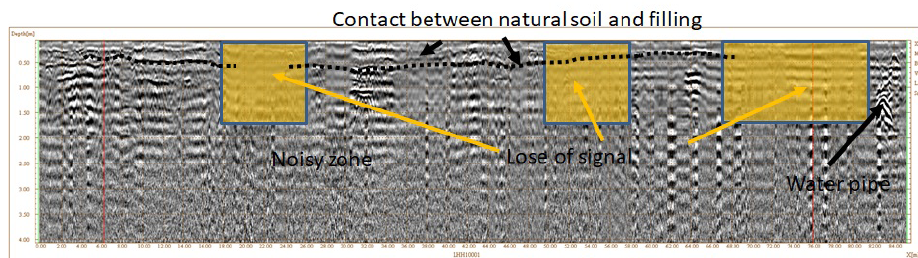
It is important to point out that the continuity of the earth fissure was disrupted by the road located at the center of the figure, which presents a lower elevation. The orange points in Fig. 1 indicate those locations in which signs of piping were recognized in the field (Fig. 2), and the green triangles indicate the locations from which soil samples were collected to be tested later in the laboratory.